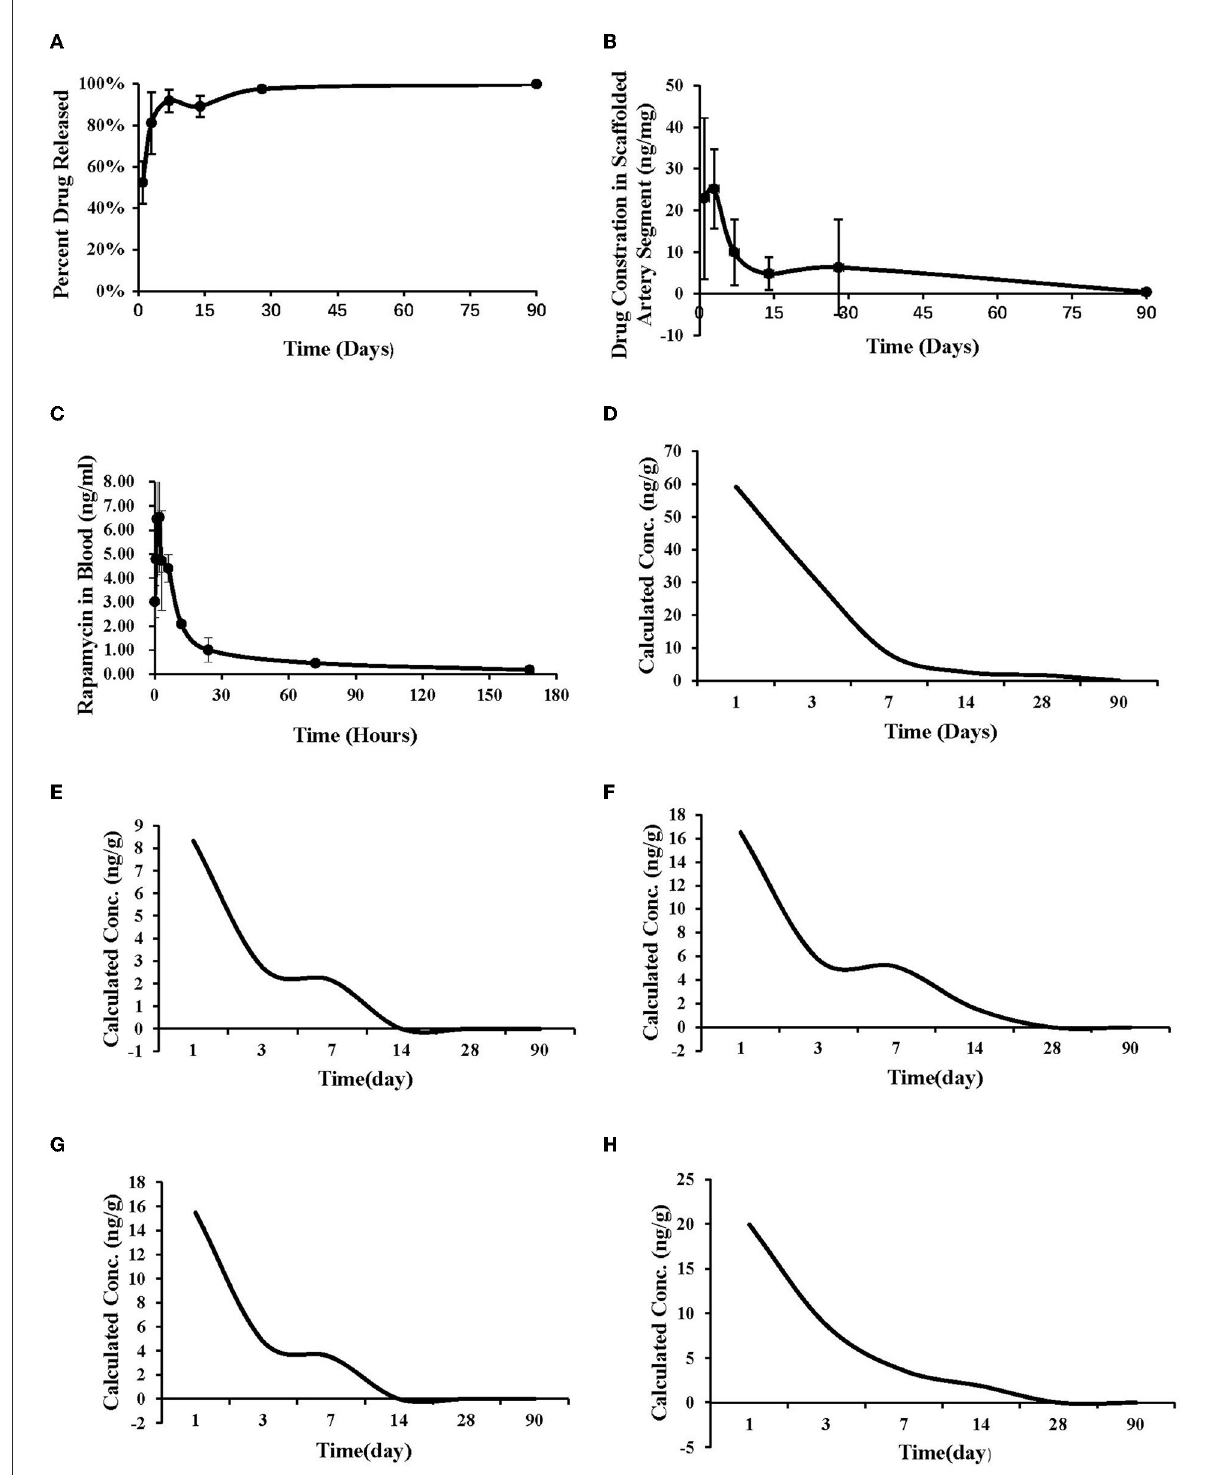
FIGURE4 Pharmacokinetic study. (A) The drug release curve. (B) The drug concentration in the implanted vascular segment. (C) The drug concentration in the whole blood after implantation. (D) The drug metabolism curve of heart. (E) The drug metabolism curve of liver. (F) The drug metabolism curve of spleen. (G) The drug metabolism curve of lung. (H) The drug metabolism curve of